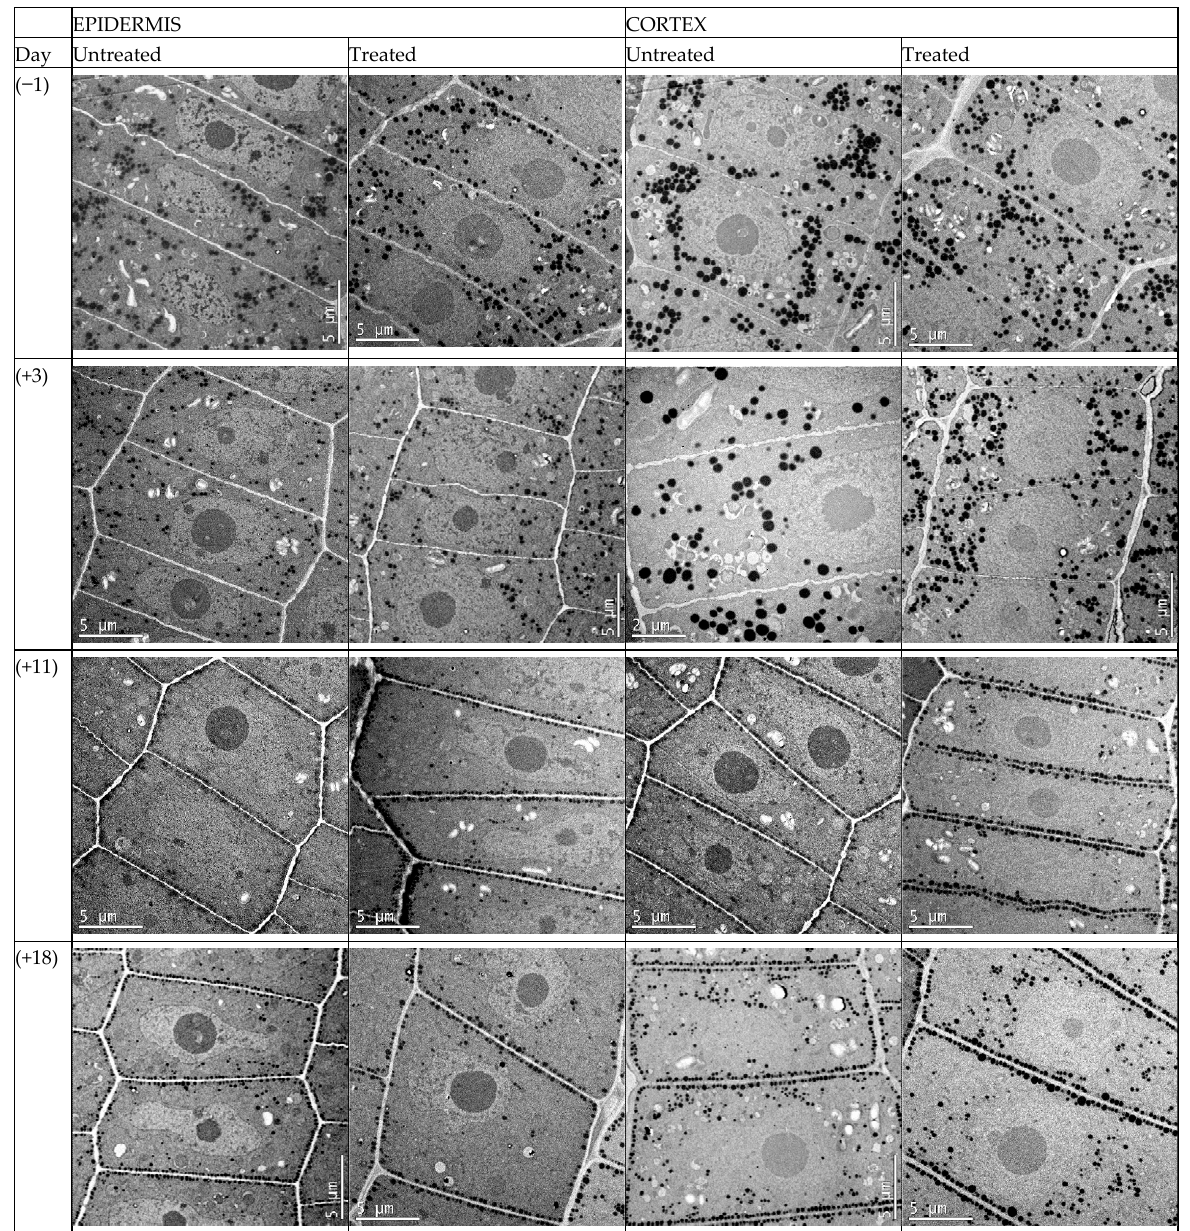
Figure 2. Transmission electron microscopy images of radicle epidermis and cortex cells. Oil body migration is recorded as seed desiccate. All images are taken at 1000×, except for cells in the cortex of untreated plants, which were photographed at 1500×. (Day) Days from defoliant application on the treated plants: day ( − 1) seeds were harvested and artificially dried with forced ambient air before defoliant application; days (+3), (+11), (+18) indicate seeds were harvested and artificially dried with forced ambient air at 3, 11, and 18 days after defoliant application, respectively. Seed moisture content was expressed on a fresh weight basis as gr H 2 O kg seed − 1 for all treatments. The seed moisture content of untreated plants was 605 on date ( − 1); 517 on date (+3); 434 on date (+11); and 375 on date (+18). The seed moisture content for seed of plants treated with a defoliant were 581 on date ( − 1); 509 on date (+3); 430 on date (+11); and 368 on date (+18). At 11 days after defoliant application, seed moisture content decreased to 434 and 400 g H 2 O kg − 1 fw in seed samples from the untreated and treated plants, respectively. The